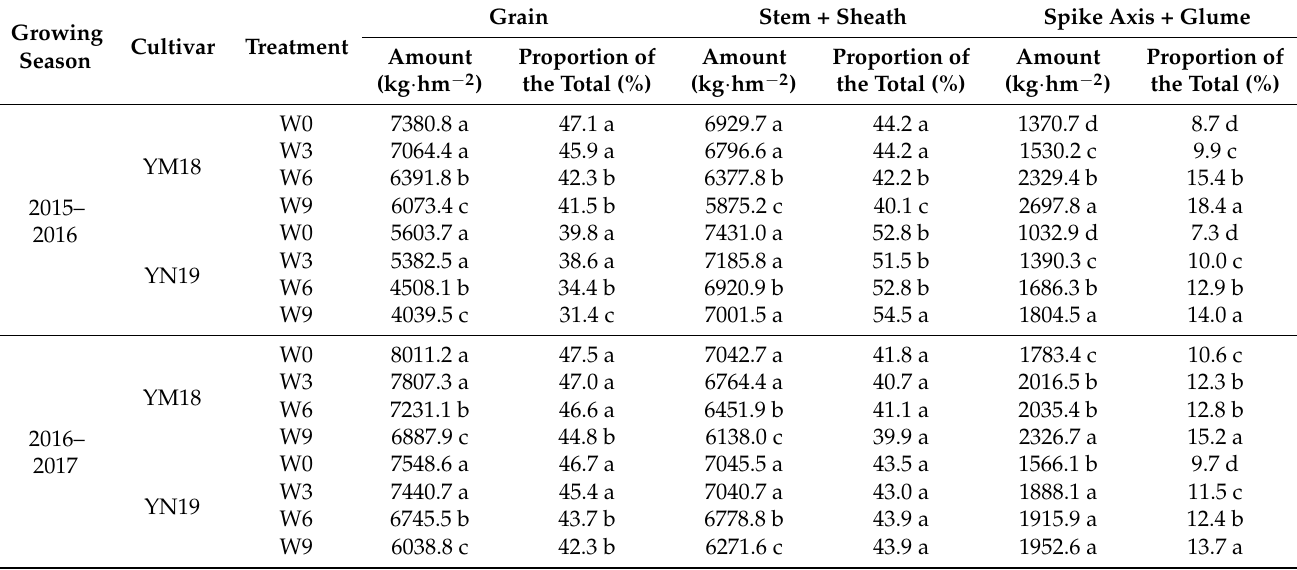
Table 4. Dry matter accumulation and its distribution at maturity stage under different treatments.